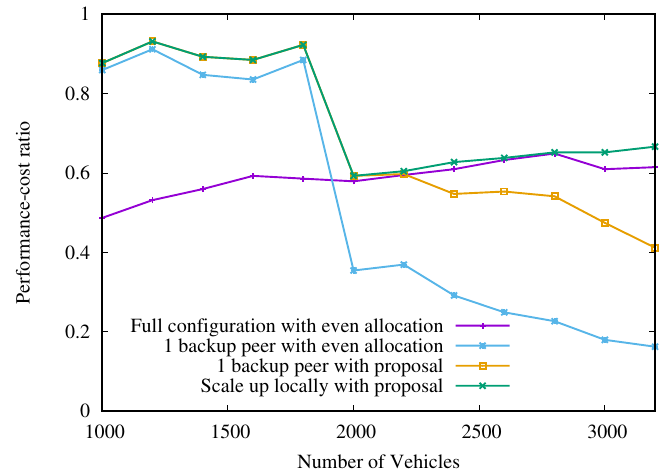
Figure 14. System latency performance-cost ratio.